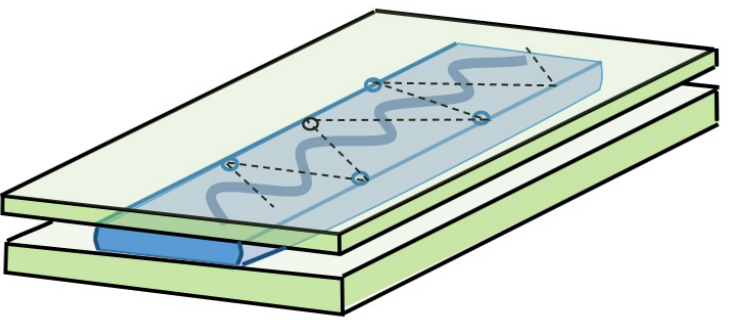
Figure 9. The developable domain structure of a thin band of a columnar mesophase, held between a slide and cover slip. Note that the only plane in which the director field can meander in response to the compressive forces is perpendicular to the viewing direction, causing all the domains to appear as nested arcs of concentric circles. The broken lines indicate domain boundaries, and the small circles show the positions of the poles of the concentric director fields. Redrawn from [21].